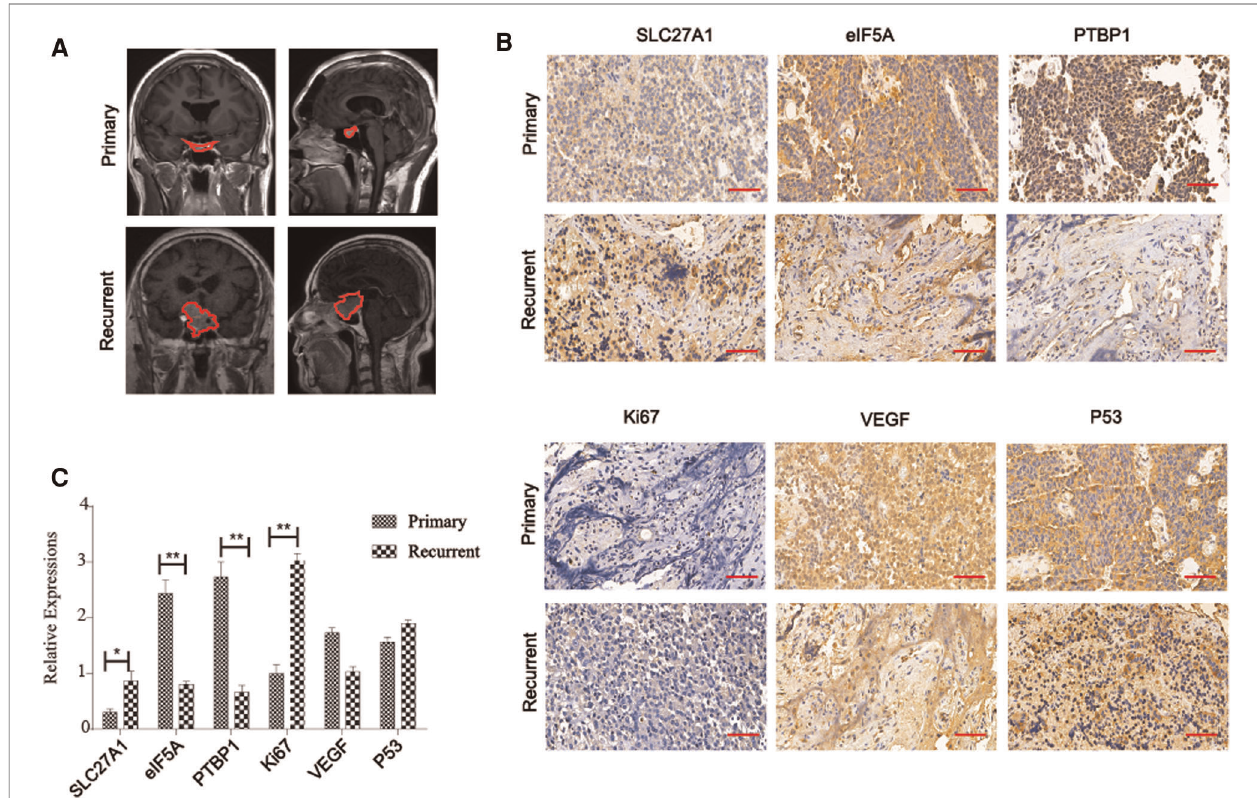
FIGURE 3 | ( A ) Imaging information of primary and aggressive pituitary adenomas, the outline of the tumor is depicted with a red dotted line. ( B ) Immunohistochemical assay to verify the expression of SLC27A1, eIF5A, PTBP1, Ki67, VEGF, and p53 in recurrent and primary pituitary adenomas ( C ) Statistical analysis of immunohistochemical